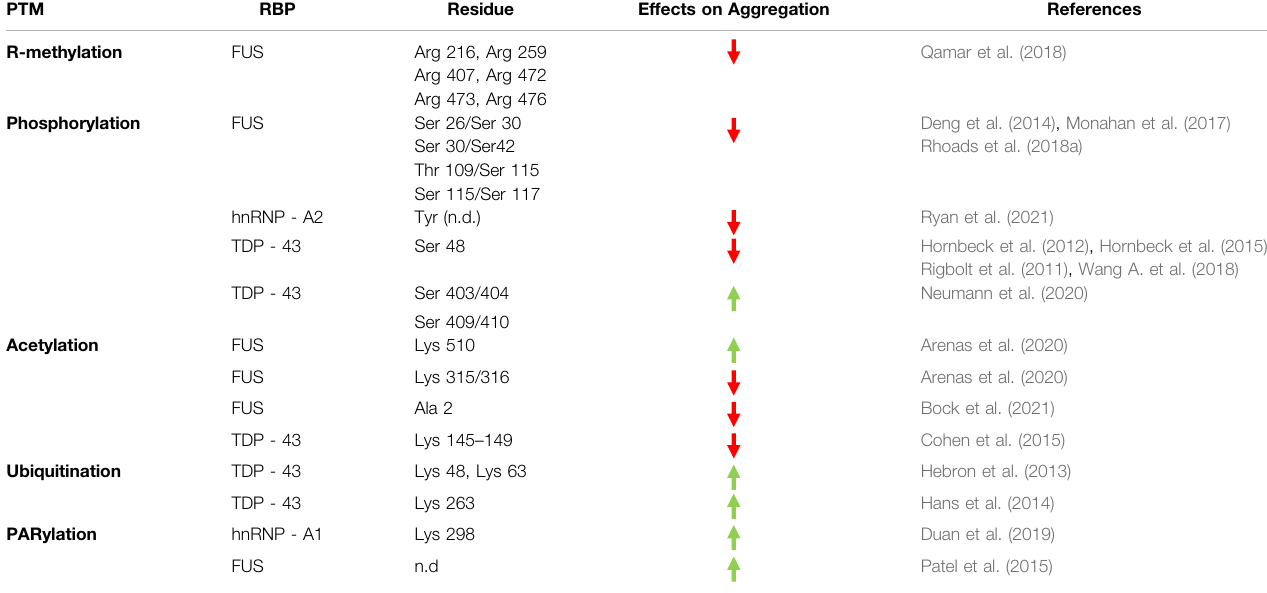
PTMs are able to both suppress (red arrow down) and enhance (green arrow up) protein aggregation of FUS, TDP43 and hnRNP-A1/A2. R-methylation mainly suppresses FUS aggregation while ubiquitination and PARylation stimulates aggregation of TDP-43, hnRNP-A1 and FUS. Other PTMs such as phosphorlation and acetylation, have been shown to suppress or enhance aggregation propensity depending on the speci fi c residue and protein modi fi